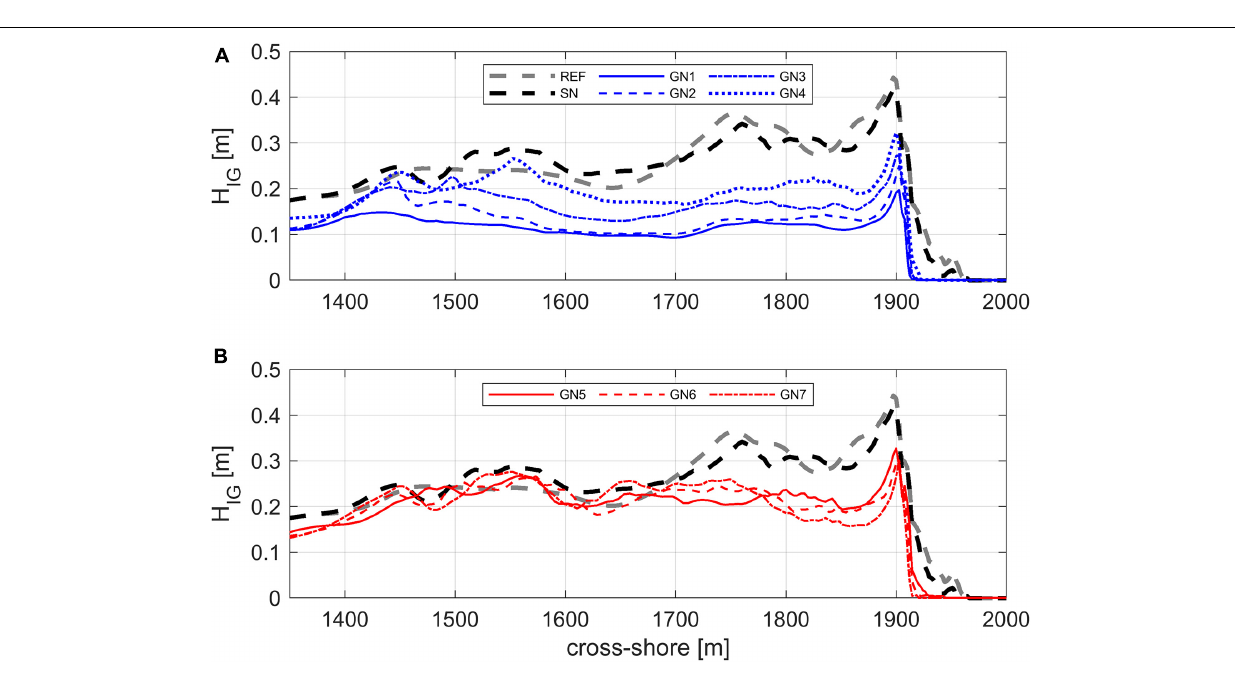
of the nourishment (Chen and Dodd, 2019). For SN, a